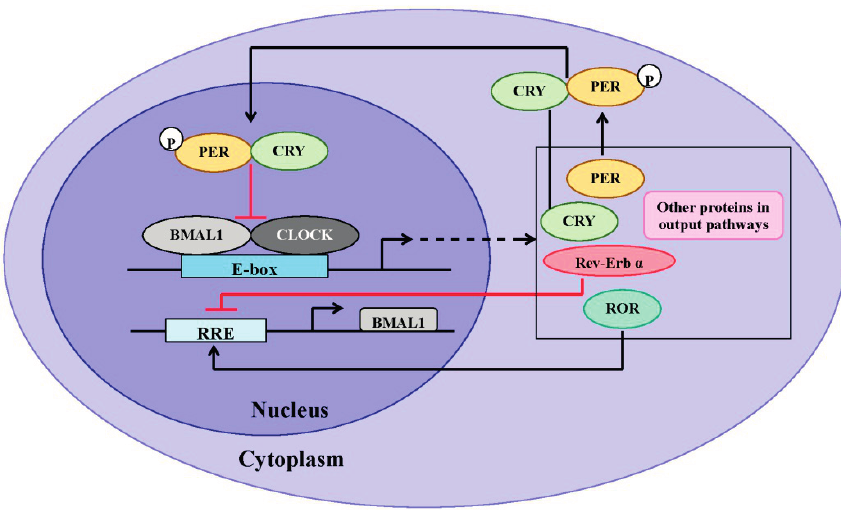
Figure 2. Transcriptional/translational feedback loops (TTFL) model of the molecular clock in mammals. The core clock genes, Brain Muscle ARNT-like protein 1 (BMAL1) and Circadian Locomotor Output Cycles Kaput (CLOCK), heterodimerize and bind to the E-box element on circadian target genes to activate transcription, including period (PER) (homologs: 1–3), cryptochrome (CRY) (homologs: 1 and 2), retinoid-related orphan receptor (ROR), Rev-Erb α and other genes in output pathways, constructing the positive arm of transcriptional/translational feedback loops (TTFL). Phospho-PER and CRY form a complex and inhibit BMAL1/CLOCK-driven transcription, constructing the negative feedback loop. ROR and Rev-Erb α also modulate the activity of the loops through increasing and inhibiting BMAL1 gene expression,